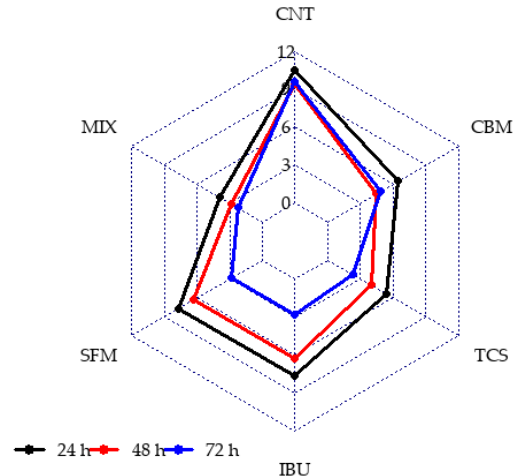
Figure 4. Viable to non-viable cell proportion in anaerobic reactors in presence of PPCPs at different culture time.